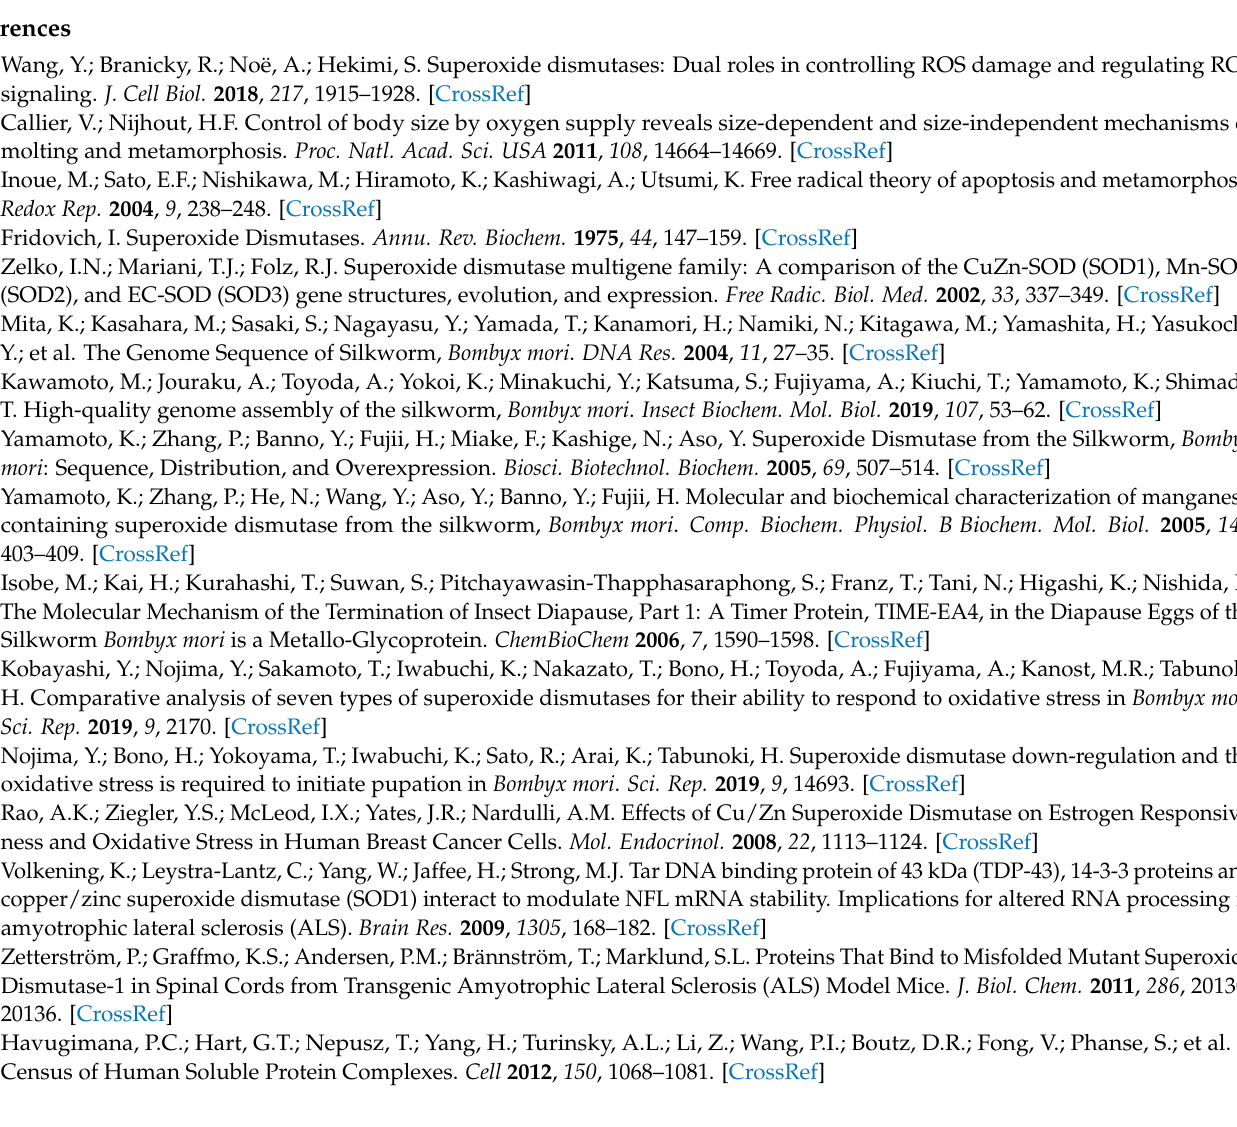
for each antibody and antiserum used for immunoblotting after co-IP. Table S2: Probes and